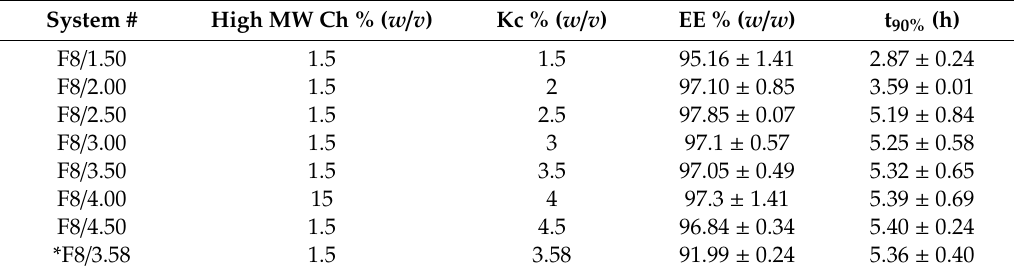
Table 2. Composition of VP-loaded polyelectrolyte complex (PEC) beads and the measured responses of the one factor